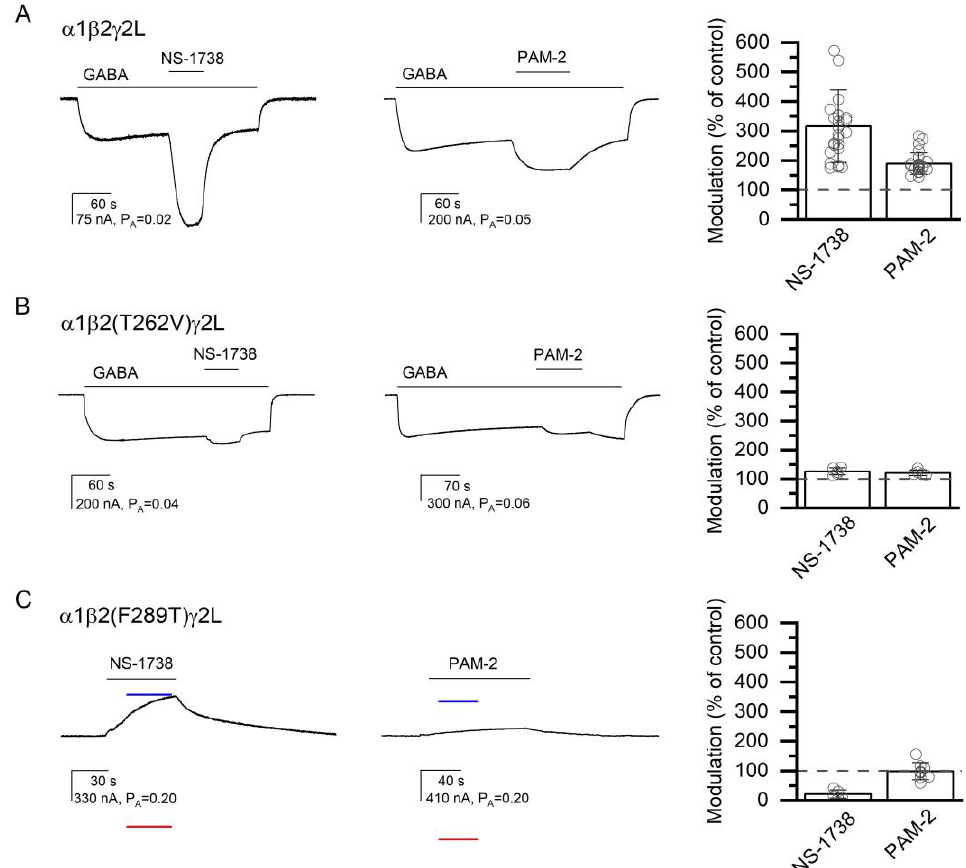
Figure 4. The modulatory effects of NS-1738 and PAM-2. The current traces show the potentiating effects of 50 μM NS-1738 or PAM-2 in the α1β2γ2L receptor activated by 2 μM GABA ( A ), or in the α1β2(T262V)γ2L receptor activated by 4 μM GABA ( B ). Panel C shows direct activation by NS-1738 or PAM-2 of the constitutively active α1β2(F289T)γ2L receptor. The blue and red lines show the current levels in the same cell in the presence of 200 μM picrotoxin (assumed P A = 0) or 1 mM GABA + 50 μM propofol (assumed P A = 1), respectively. The modulatory effects are summarized in the column graphs. In ( A , B ), modulation is calculated as the amplitude of the peak response to GABA + α7-PAM divided by the amplitude of the response to GABA alone at the time of peak response to GABA + α7-PAM. In ( C ), modulation is calculated as the ratio of the estimated P A in the presence and absence of α7-PAM. Drug application durations are given with horizontal lines.